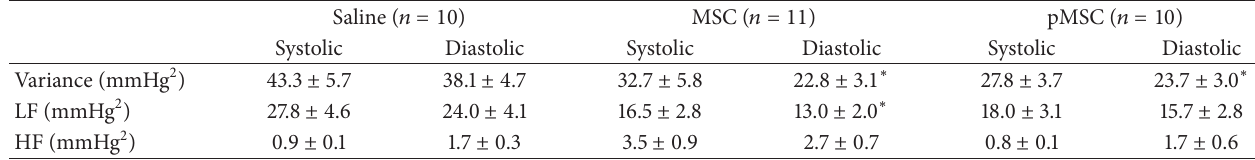
Table 1: Effect of stem cell treatment on arterial pressure variability in all three experimental groups.